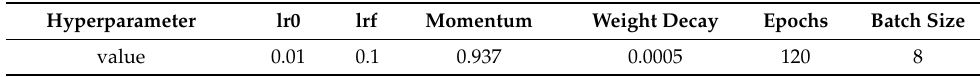
Table 2. The setting of hyperparameters.